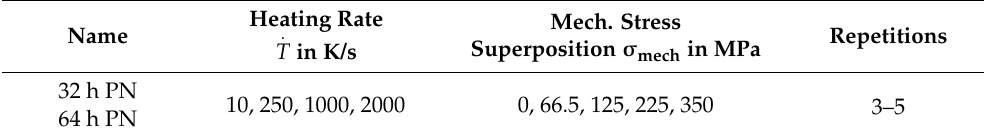
Table 2. Test parameters for the investigation of austenitisation behaviour.